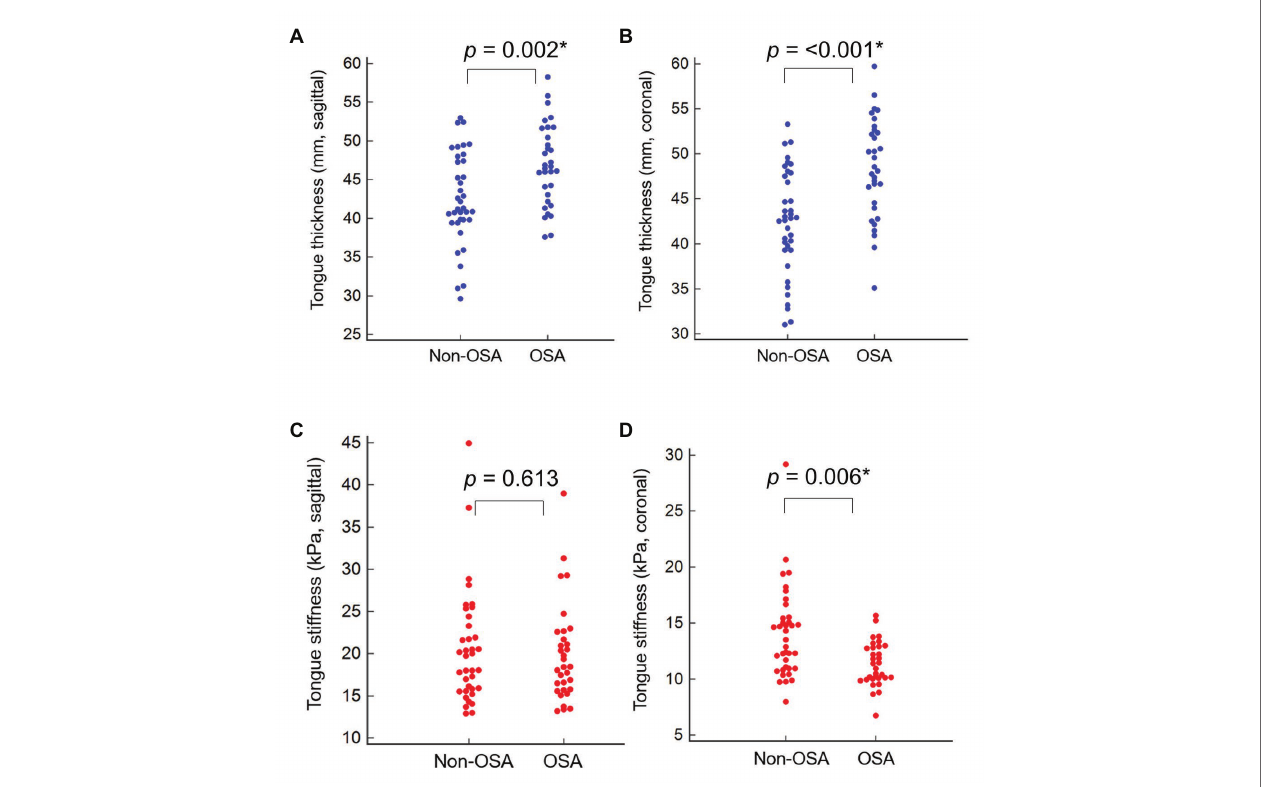
FIGURE 4 | The dot plots demonstrated the individual measurements of tongue muscle thickness in the sagittal (A) and coronal (B) views and tongue muscle stiffness in the sagittal (C) and coronal (D) views. OSA, obstructive sleep